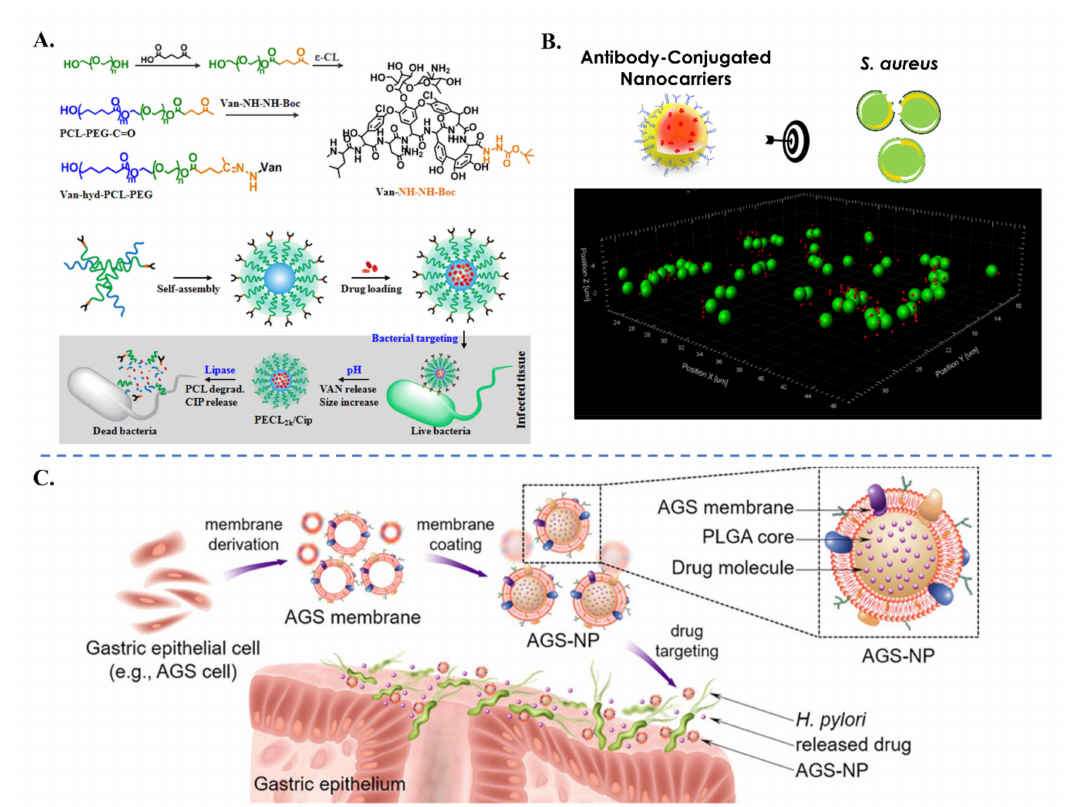
Figure 9. Active targeting of antibiotic-loaded nanocarriers to bacterial cells. ( A ) Schematic illustrations of formation, bacterial targeting, and drug release from micelles with vancomycin-mediated targeting (reprinted with permission from [54], copyright 2018 ACS). ( B ) Schematic illustrations of antibody-conjugated nanocarriers for targeted antibiotic delivery, and 3D fluorescent image showing a specific interaction between targeted NPs (red sphere) and S. aureus (green sphere) (adapted with permission from [33], copyright 2021 ACS). ( C ) Schematic illustrations of the application of gastric epithelial cell membrane-coated NPs for targeted antibiotic delivery to treat H. pylori infection (reprinted with permission from [110], copyright 2018 John Wiley and